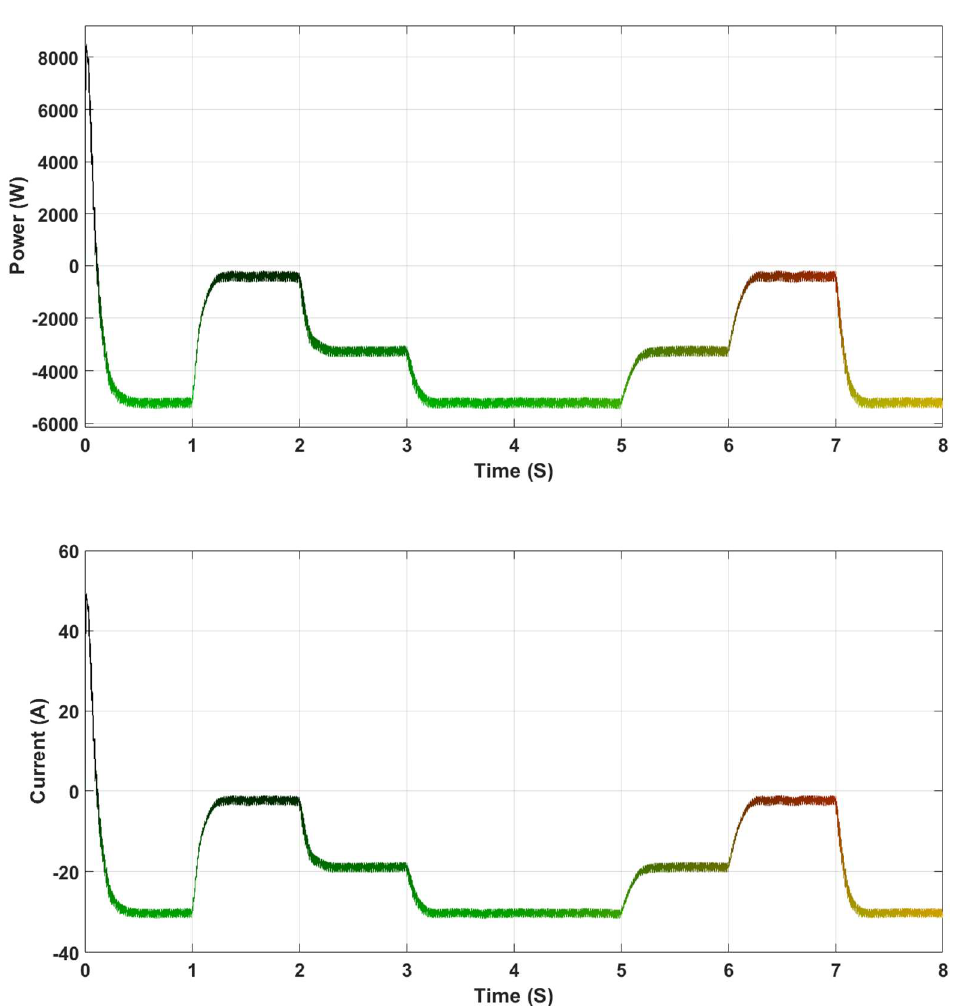
Figure 23. Battery power and current.